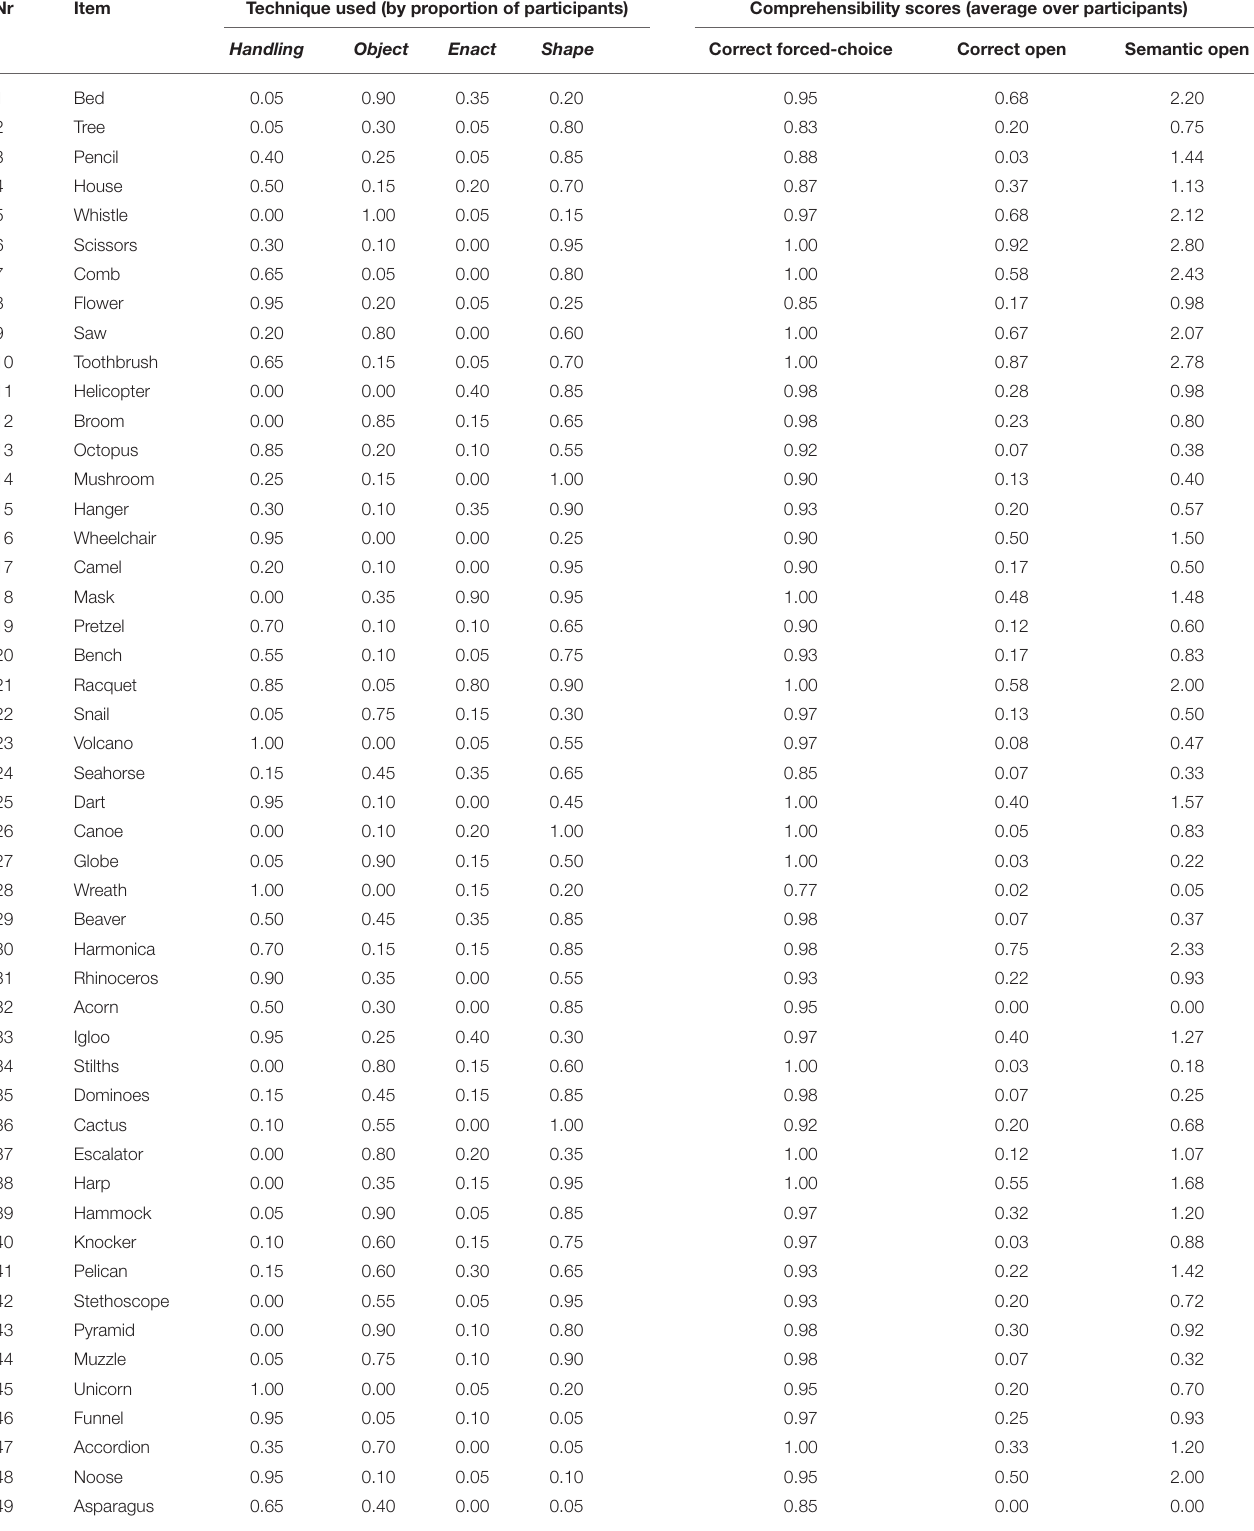
TABLE 3 | Representation techniques used by proportion of participants and comprehenisbily scores (averaged over participants) per item.